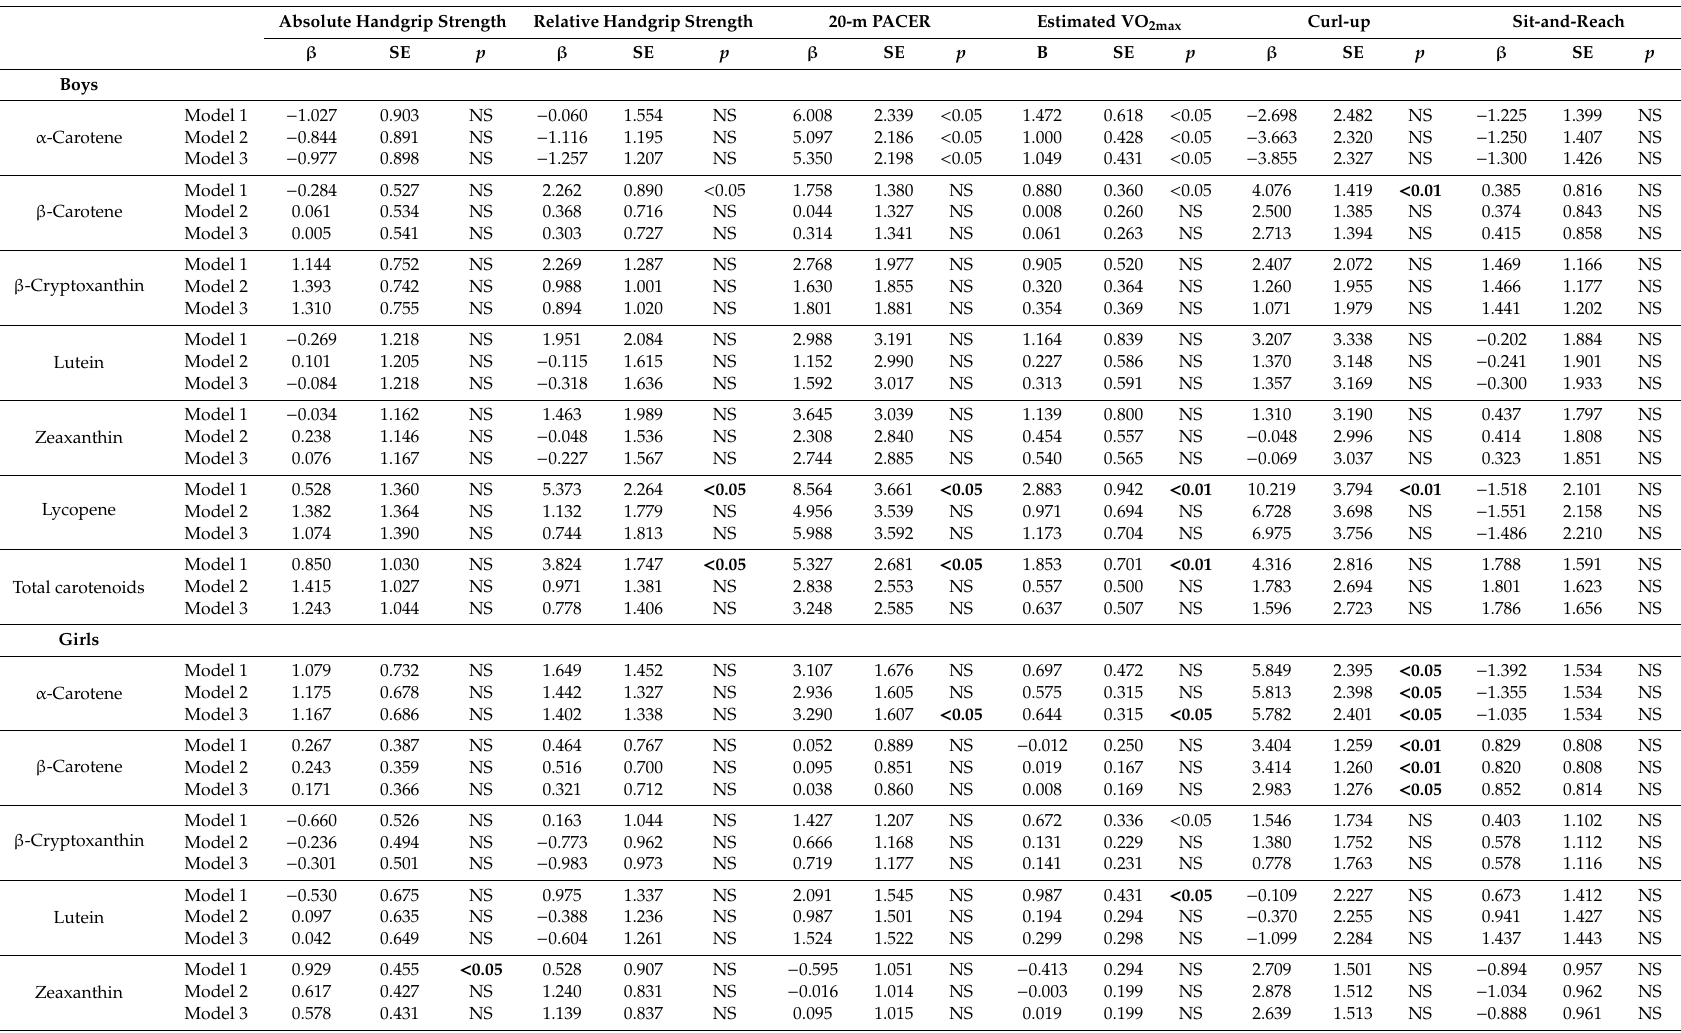
Table 4. Multiple linear regression analysis for the association between blood carotenoid levels and physical performance in